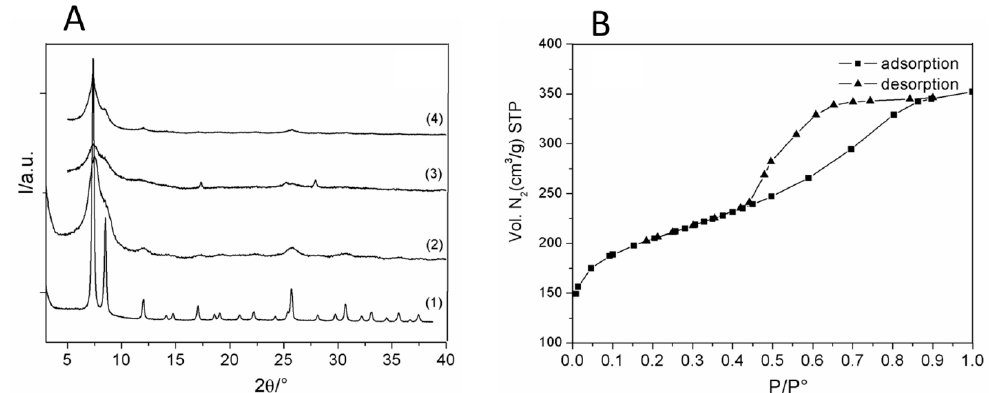
Figure 1. ( A ) XRPD patterns for UiO-66_N 100 (1), UiO-66_N (2), UiO-66_N soaked overnight in chloroform (3), and UiO-66_N@Acr (4); ( B ) N 2 adsorption-desorption isotherms for sample UiO-66_N measured at 100 K.